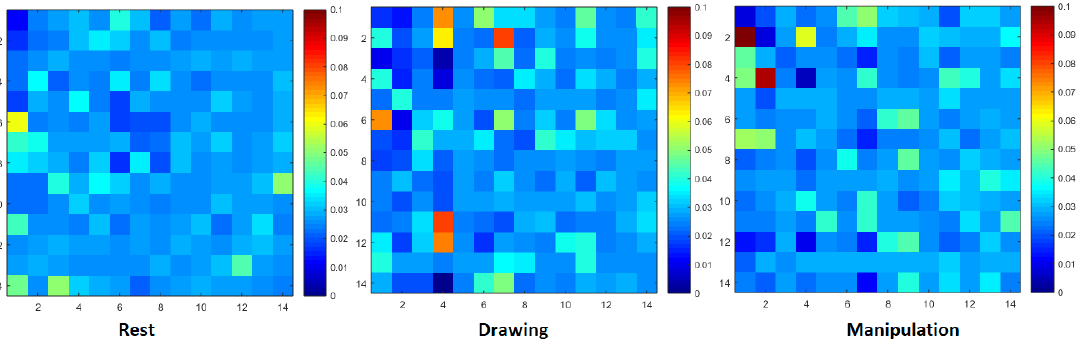
Figure 3. Normalized transfer entropy matrix during rest, drawing and manipulation states of novice user.